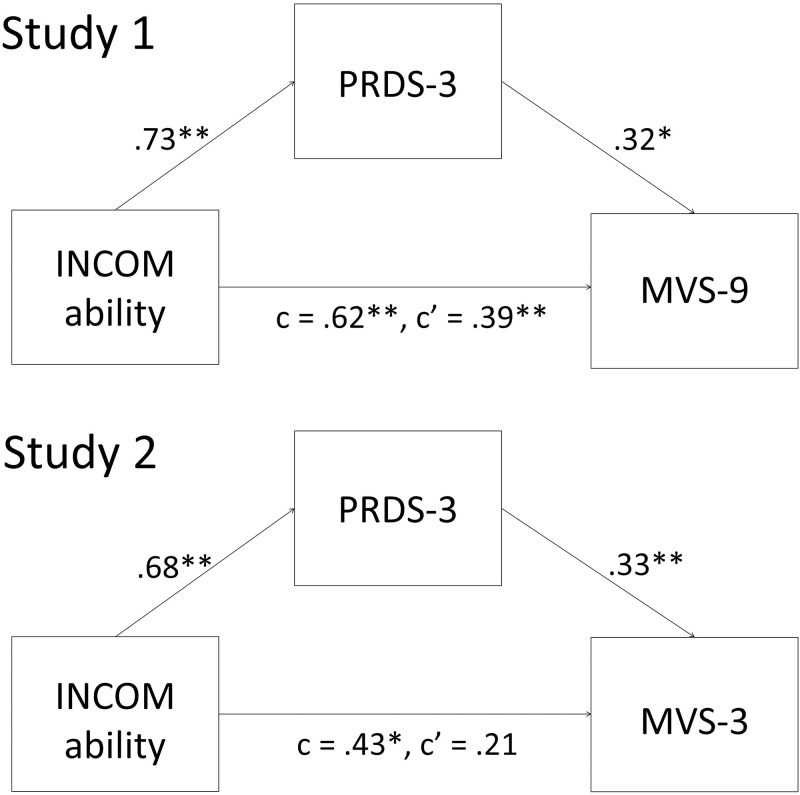
Mediation models for Studies 1 and 2.INCOM = Iowa-Netherlands Comparison Orientation Measure; PRDS = Personal Relative Deprivation Scale; MVS = Material Values Scale. Values depict unstandardized regression coefficients. ** p < .001, * p < .01.